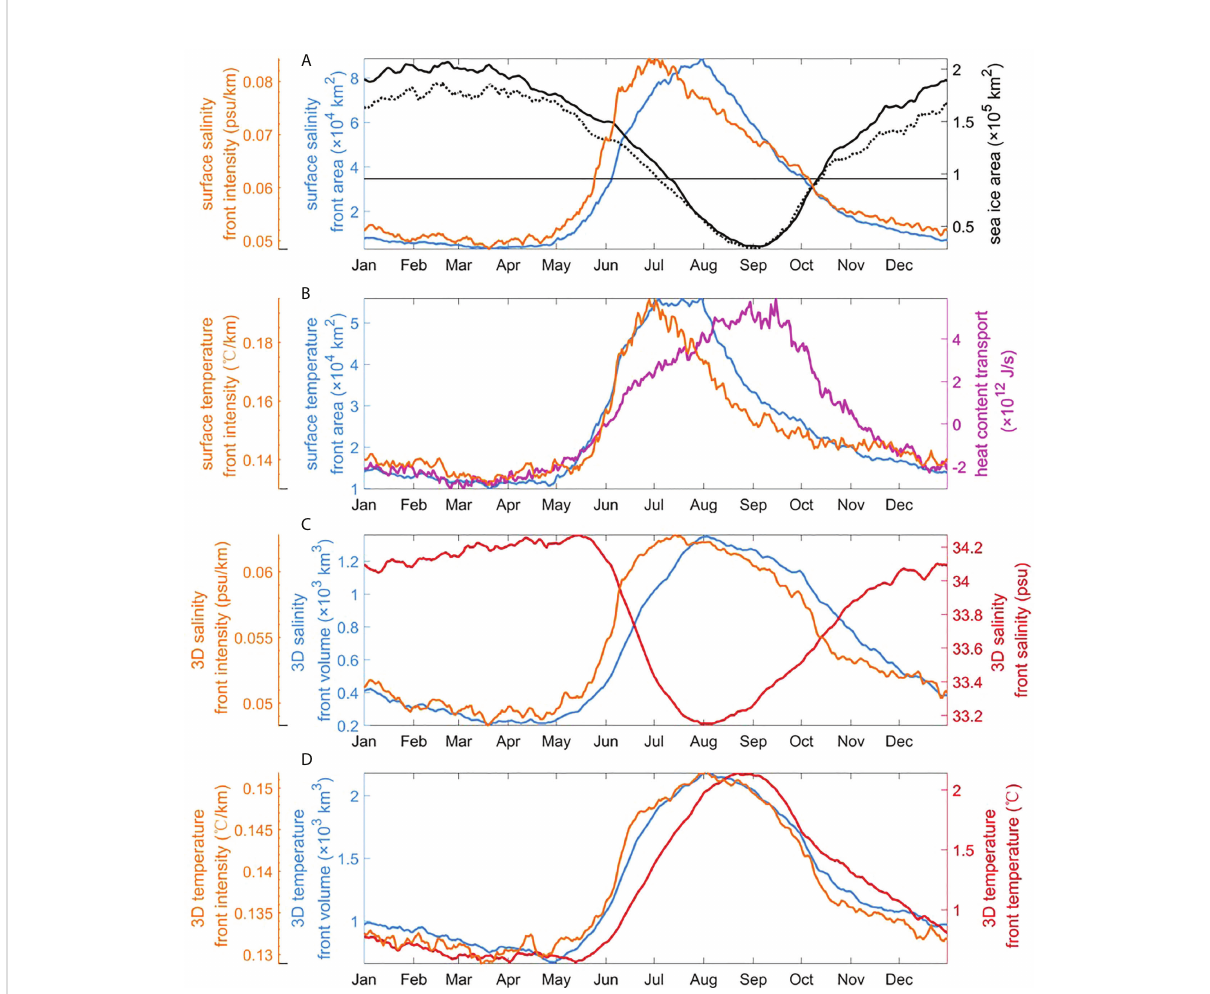
FIGURE 6 Seasonal variations. (A) Surface salinity front intensity, area and sea ice area. The thick black solid/dashed line refers to the GLORYS12v1/remote sensing data results. The thin solid black line represents the continental shelf area of the research area. (B) Surface temperature front intensity, area, and heat content transport along the upper 25-m section (red line) indicated in Figure 1A. (C) 3D salinity front intensity, volume, and averaged salinity. (D) The 3D temperature front intensity, volume, and averaged